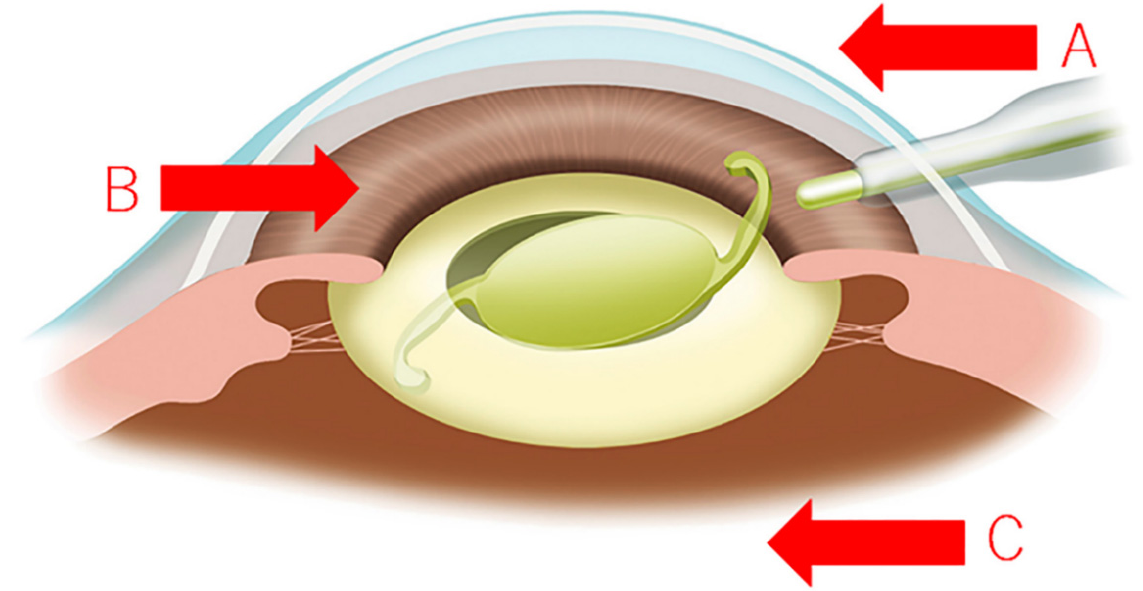
Figure 4. Prevention of endophthalmitis after cataract surgery (three-step approach); ( A ) The most important measure is “border control” to prevent bacteria, fungi, viruses and other microorganisms from entering the eye. ( B ) The second measure is to thoroughly wash out the bacteria that have entered the anterior chamber. ( C ) For the third measure, bacteria that remain in the anterior chamber and vitreous are eliminated by antibacterial drugs. As a “border control” measure, it is useful to irrigate the ocular surface with 0.25% povidone-iodine every 20–30 s during cataract surgery to transiently sterilize the ocular surface instead of washing with physiological saline. (Authors’ unpublished images).